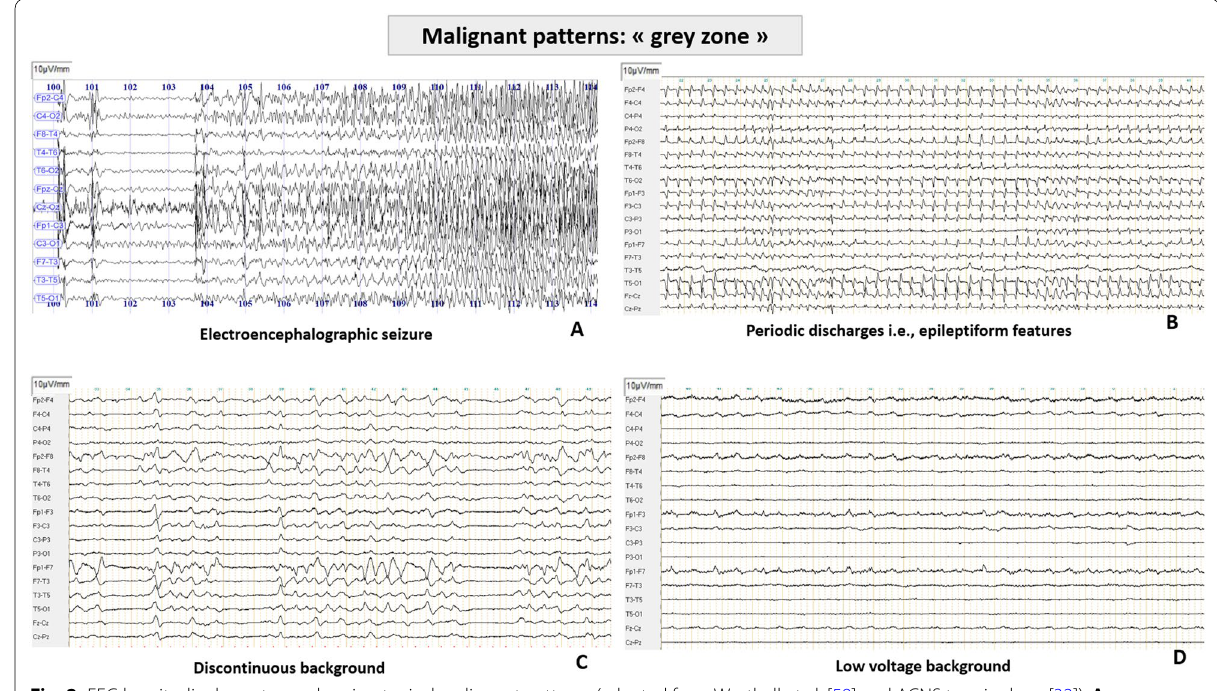
Fig. 2 EEG longitudinal montages showing typical malignant patterns (adapted from Westhall et al. [58] and ACNS terminology [32]). A Electroencephalographic seizure with high frequency (> 2.5 Hz) generalized spikes, more broadly defined as pattern with epileptiform discharges > 2.5 Hz for 10 s or any pattern with definite spatial and temporal evolution lasting 10 s. B Generalized periodic pattern (i.e., ≥ ≥ epileptiform features) defined as non‑evolving and low frequency (<2.5 Hz) periodic discharges (spike, sharp or wave) during > 50% of the recording, without suppressed background. C Discontinuous background defined as suppression periods (< 10 µV) constituting > 10% but < 49% of the recording. D Low voltage background defined as amplitude of the background < 20 µV. Unreactive EEG is not illustrated